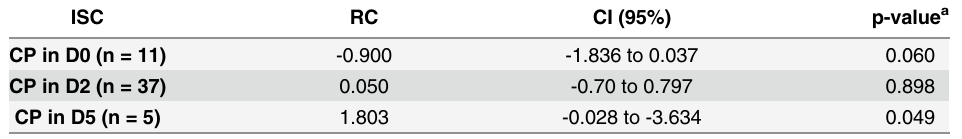
Table 5. Stratified analysis for ISC for corticomeningeal